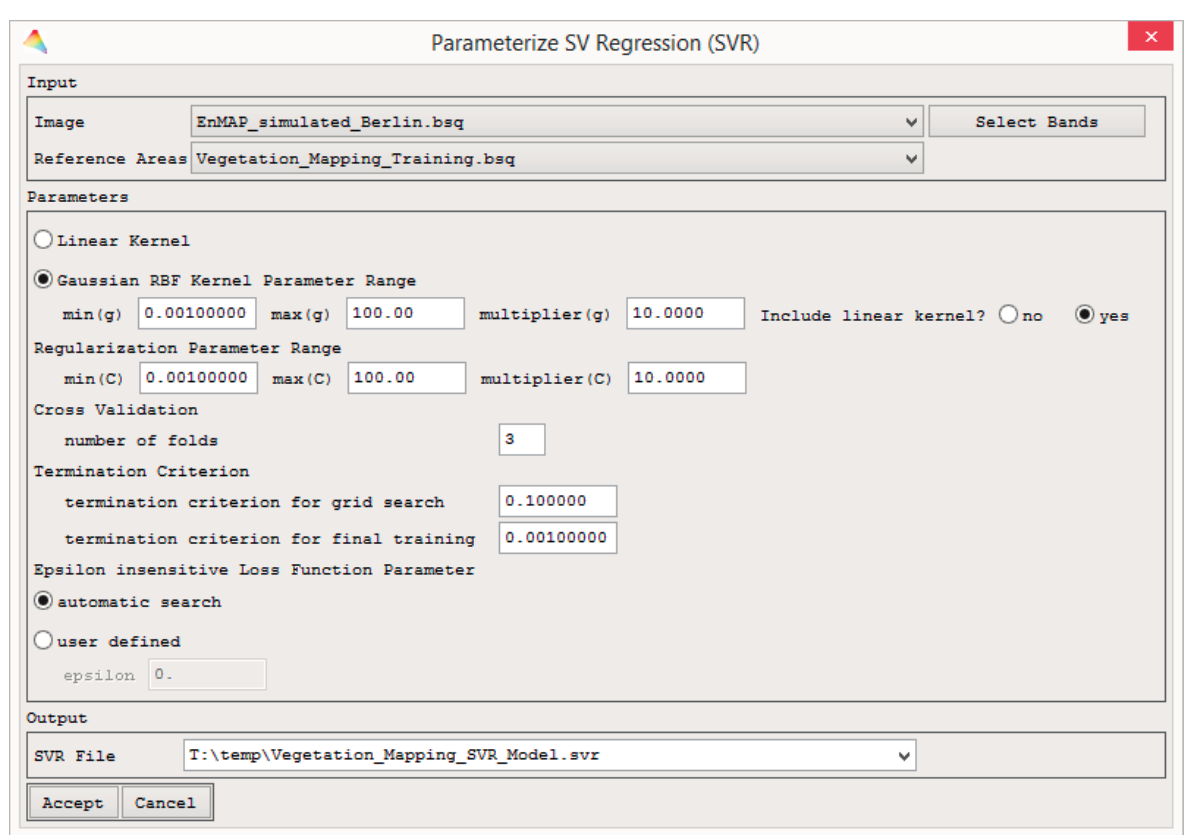
Figure 3. Dialogue for and advanced SVM regression settings in imageSVM. The dialogue for the regular settings is limited to the Input and Output fields.